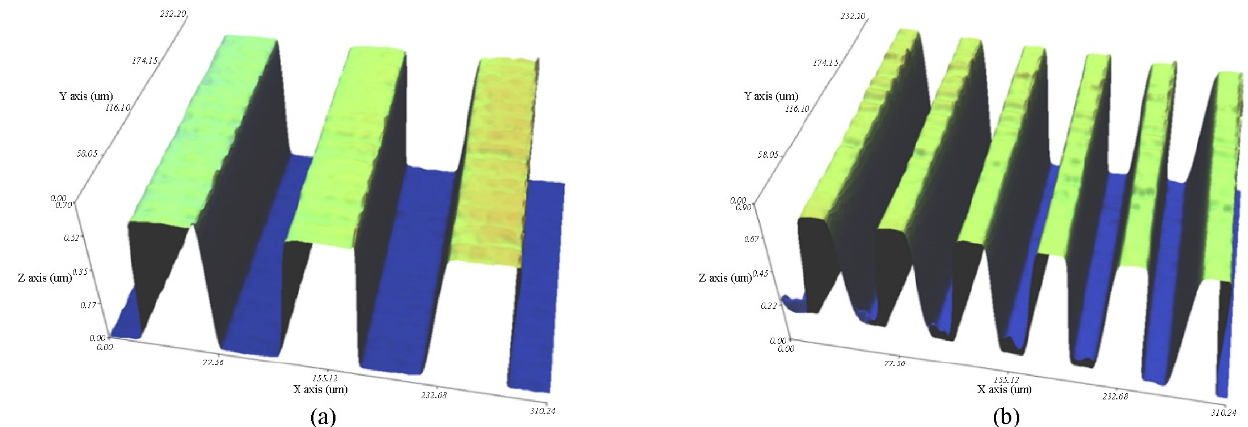
Figure 3. Information on the Cu-patterned wafer. ( a ) Layout of the Cu patterns and the patterns considered in the experi- ment and ( b ) the cross-sectional view of the patterned wafer.